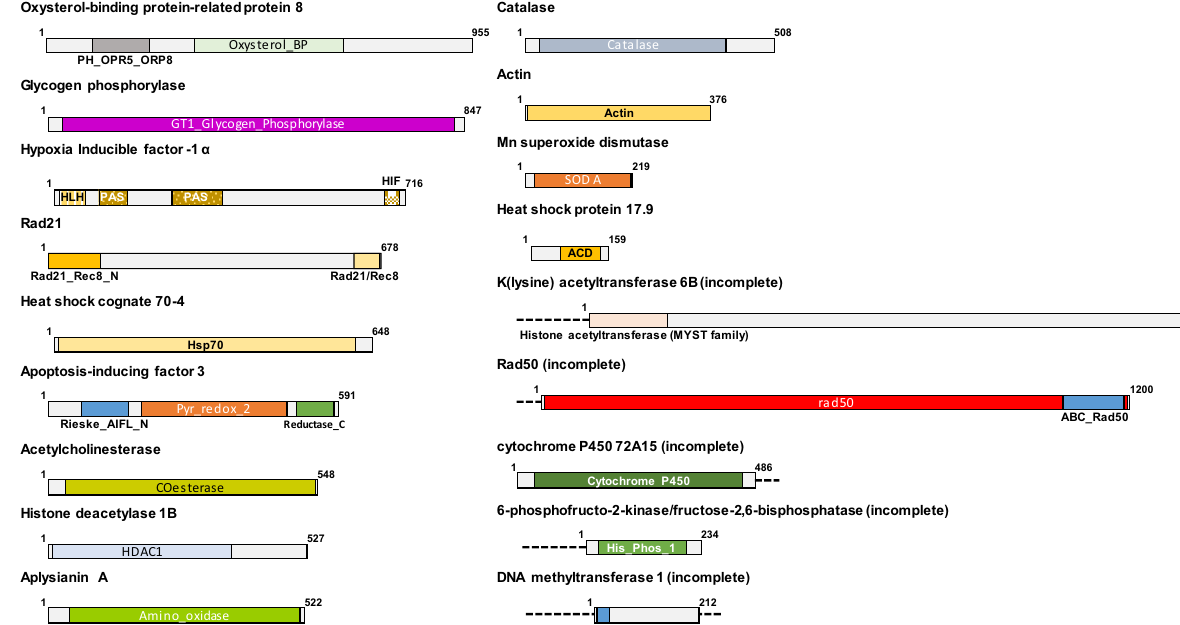
Figure 1. Structure and conserved domains of the identified Physella acuta proteins. Each protein corresponds to an open reading frame from the sequences used in the study. The proteins are shown with the different motifs that characterize them. The domains are defined according to the CCD functional classification of proteins. Some of the genes were not complete, and the discontinuous line indicates the unknown up- and down-stream